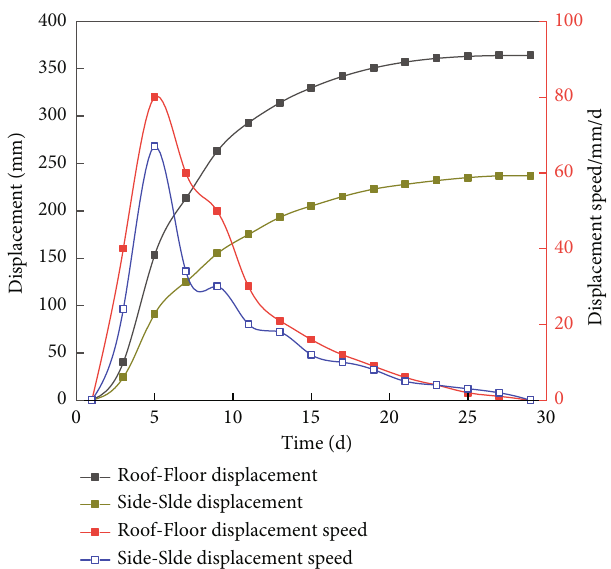
Figure 18: Deformation curve of roadway under dynamic